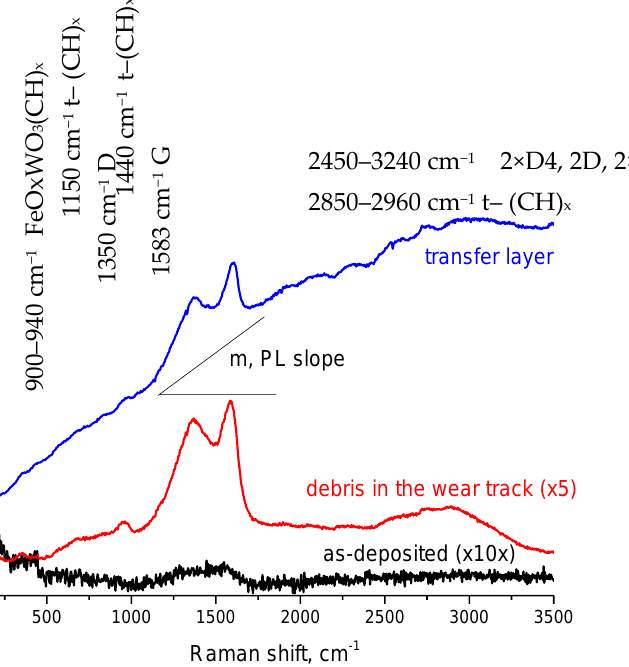
Figure 14. Raman spectra in the debris and in the transfer layer in W-C:H coating 1C 2 H 2 –15H 2 (see Figure 12d) after 6400 m–long friction test in humid air zone (reprinted with permission from Ref. [26], 2021, Elsevier).